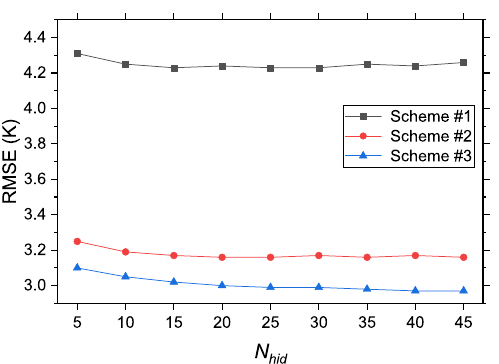
Figure 8. RMSEs of different modeling schemes after combination ( N ens =